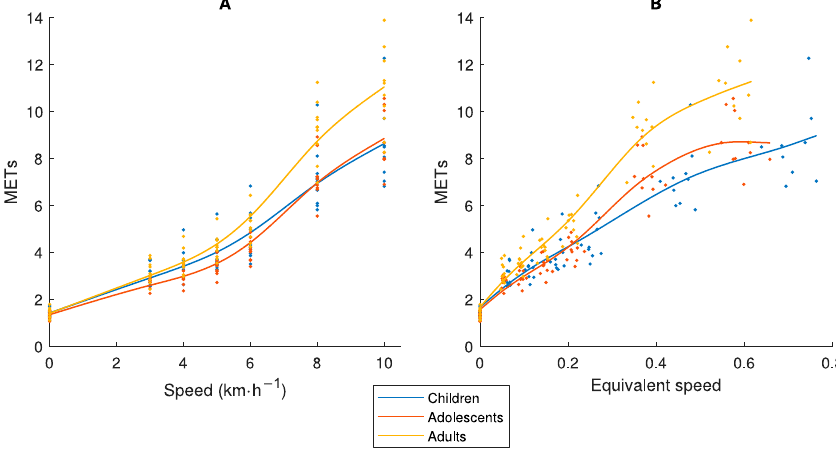
Figure 3. Relationship between ( A ) Speed abs or ( B ) Speed eq and Metabolic Equivalent of Task (MET), in children 9–11, adolescents 14–16 and adults 23–44 years old.